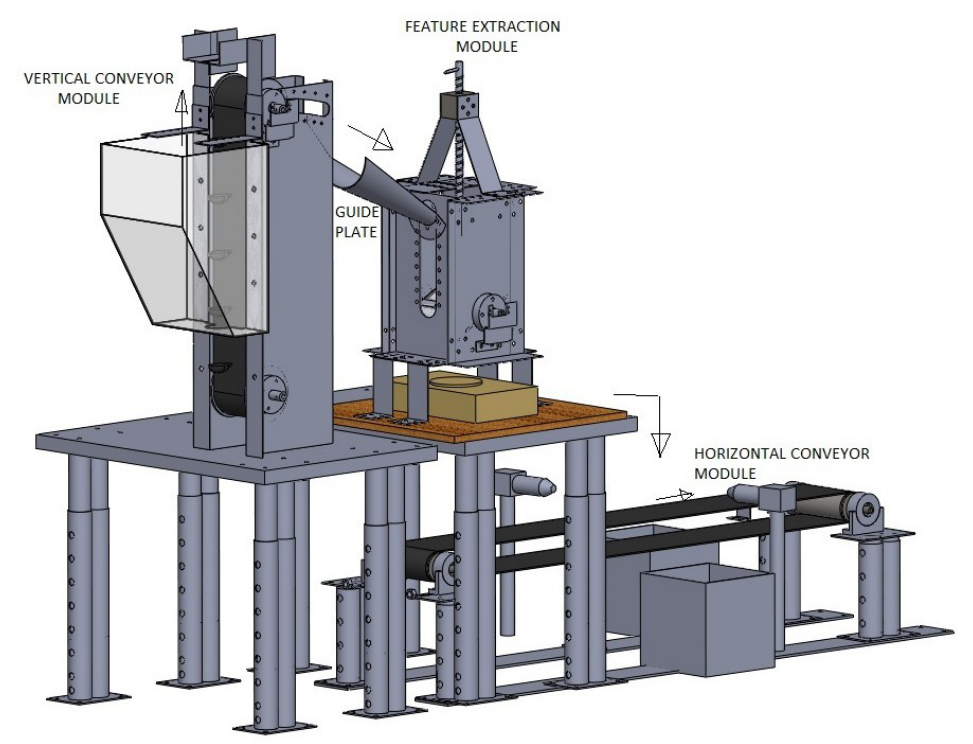
Figure 5. 3D model of silkworm cocoons separating machine.